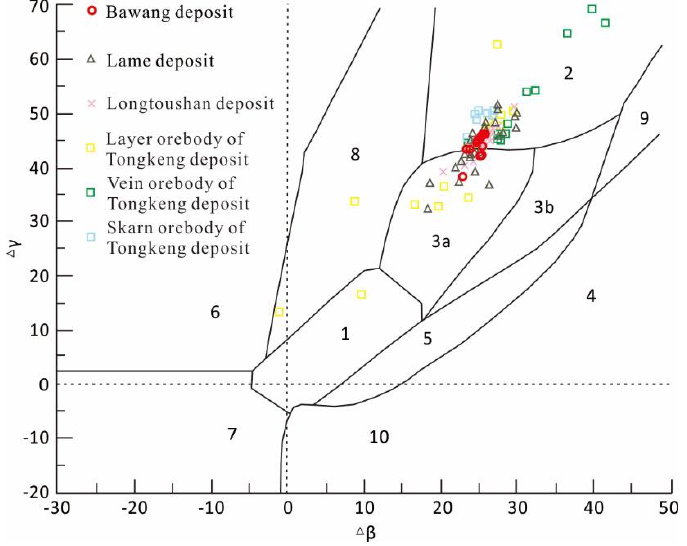
Figure 11. Genetic classification of Pb isotope Δγ–Δβ (base map according to Zhu et al. [81], the data of other deposit come from [17,21,24,30,53,72,82–85]).